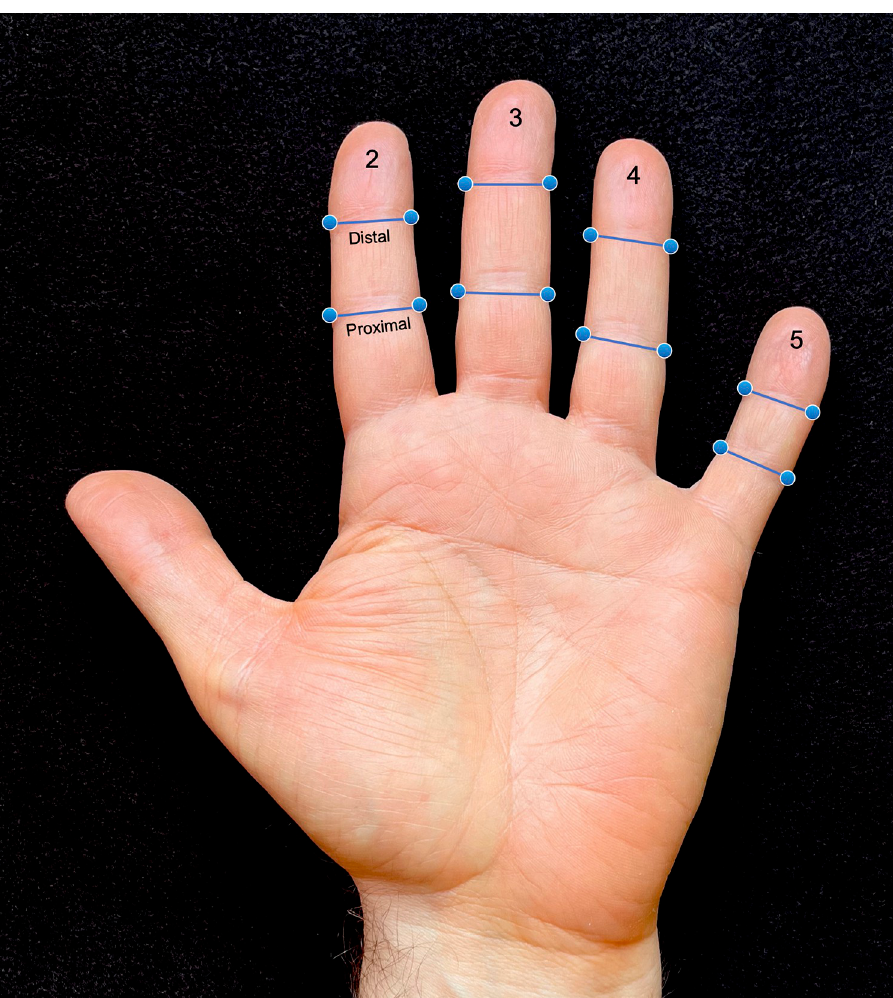
Fig 1. Image showing landmarks and distances used to quantify finger tapering. Landmarks were placed at the radial and ulnar margins of the creases corresponding to the proximal and distal inter-phalangeal joints of fingers 2–5. From these landmarks, finger widths were calculated at the proximal and distal joints on each finger on each hand. The tapering index was then calculated by dividing the distal inter-phalangeal joint width by the proximal inter-phalangeal joint width for each finger. Measures were not collected on the thumb (first finger). Identical measures were collected on the right hand (not shown